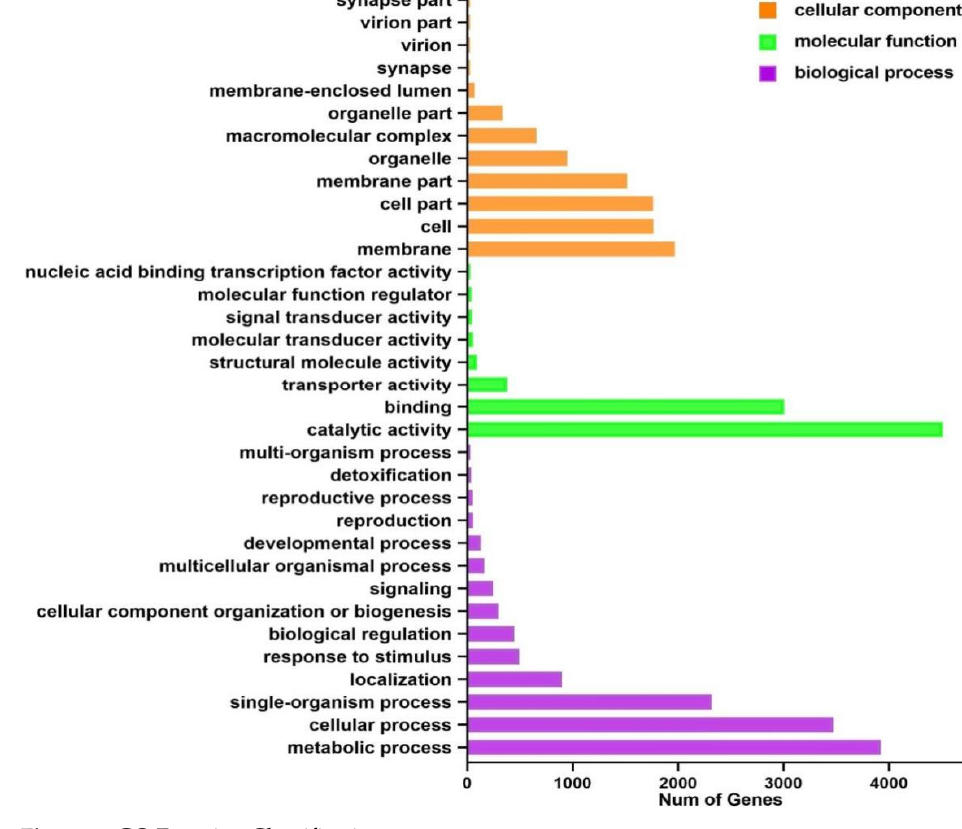
Figure 4. GO Function Classification.